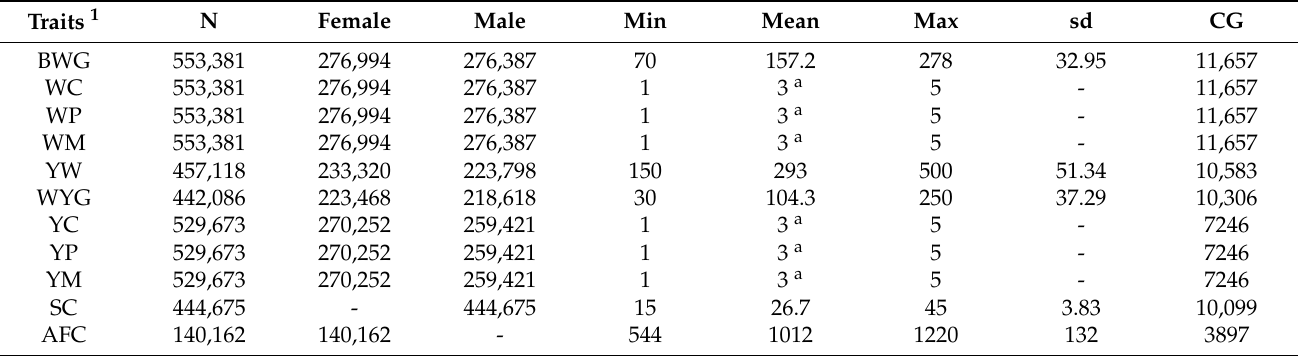
Table 1. The data editing (removing the missing data and outliers) was carried out using R software [20]. Table 1. Summary statistics of the dataset for each evaluated trait, considering the number of animals (N), number of males and females, minimum (Min), maximum (Max), mean (or median), standard deviation (sd), and the number of contemporary groups (CG).